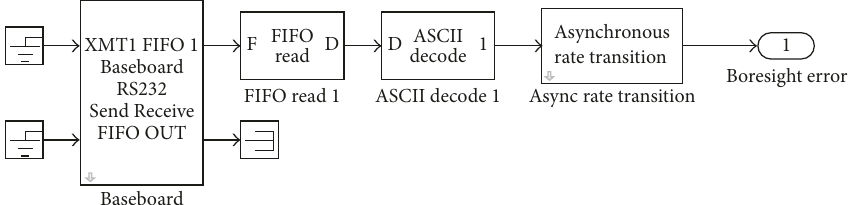
Figure 15: TV Seeker subsystem.